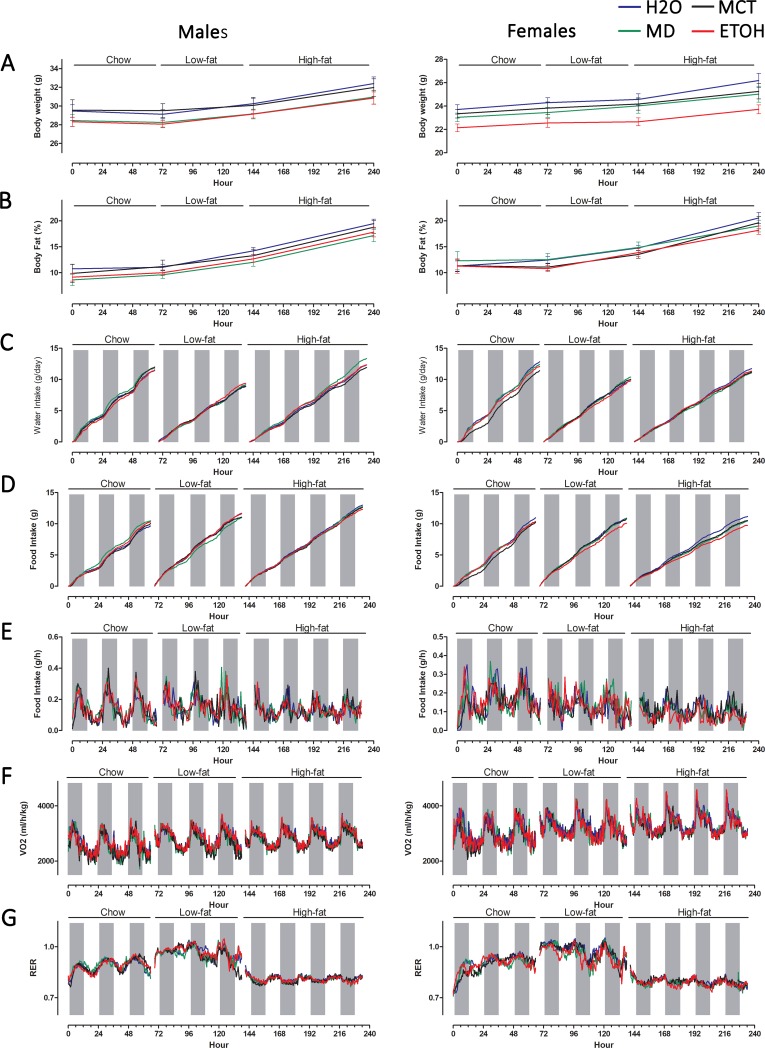
PAE does not alter whole body metabolism in adult male and female mice.Male and female offspring were evaluated for food intake and whole body metabolism using environmental chambers. The individual’s ability to adapt its metabolism and food intake to diet composition was assessed by sequential feeding of chow diet (3 days), low fat diet (10%, 3 days), and high fat diet (60%, 4 days). Body composition was assessed at the beginning and end of each diet challenge using NMR. (A) Body weight at the beginning and end of each diet challenge did not differ by treatment in males (left panel) and was reduced in ETOH females only during chow feeding. (B) The percentage of body size as fat mass increased on the low-fat and high-fat diets, but was not affected by PAE or other treatments in male and female offspring. (C) Cumulative water intake (measured hourly) was not affected by prenatal treatment in either sex. (D) Cumulative food intake increased on the low-fat and high-fat diets compared with chow diet, but did not differ with respect to prenatal treatment. (E) Hourly food intake showed similar patterns across the dark/light cycle in males, and was significantly affected by prenatal treatment in females, as detailed in the text. (F) Oxygen consumption (VO2, ml/h/kg) showed diurnal variation consistent with food consumption pattern and activity, and was unaffected by prenatal treatment in either sex. (G) The calculated respiratory exchange ratio (RER) showed diurnal variation consistent with the pattern of food intake and, as expected, was increased with the low-fat diet and decreased with the high-fat diet. RER was not affected by PAE or other prenatal treatments in either sex. Shaded bars represent the dark cycle when mice are more active. Values are mean ± SEM of 8–10 offspring per sex*treatment group; SEMs are omitted from panels C-G for clarity. Blue, H2O; Green, MD; Black, MCT; Red, ETOH.